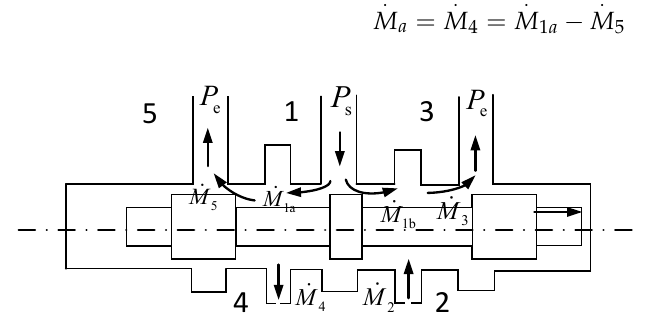
Figure 4. Proportional directional control valve core forward movement of the flow schematic of the gas.